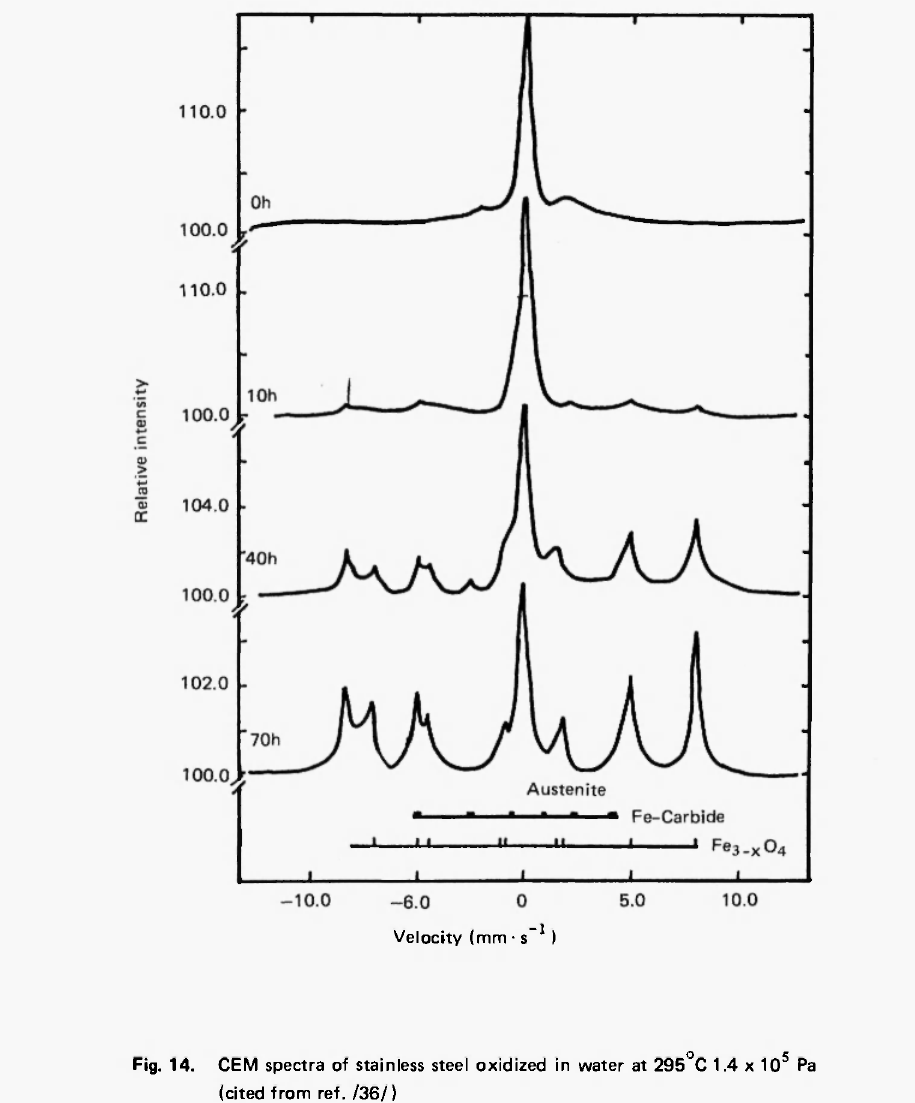
Fig. 14. CEM spectra of stainless steel oxidized in water at 295 3 C 1.4 χ 10 5 Pa (cited from ref.